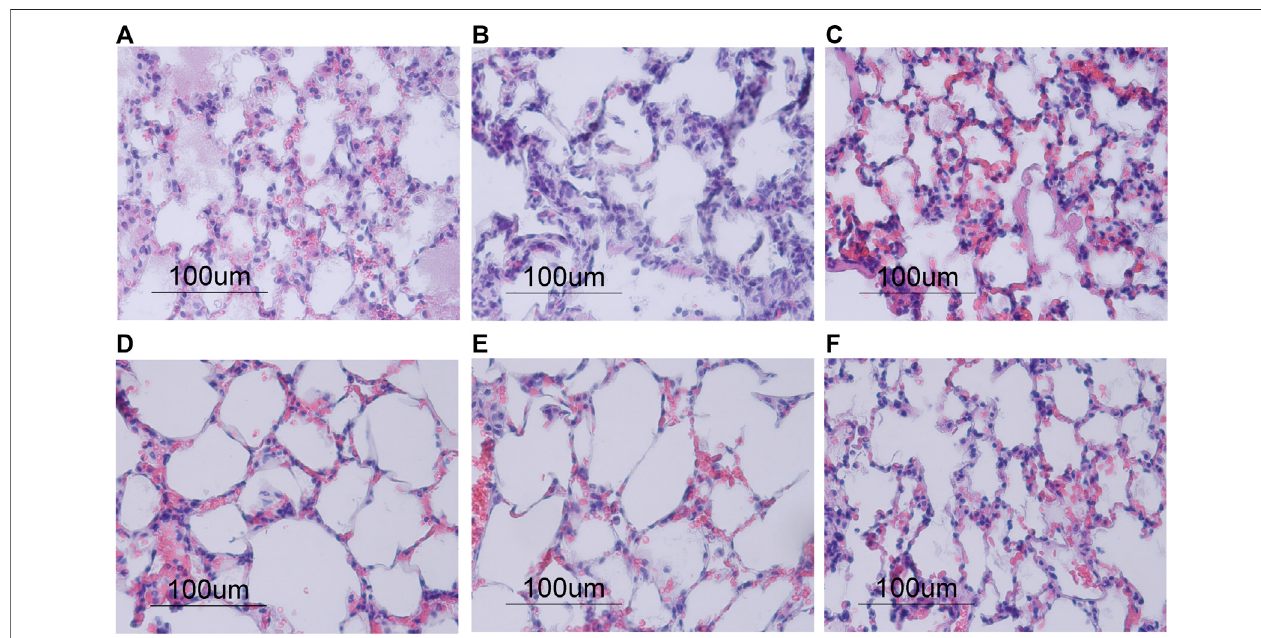
FIGURE 5 | Morphological changes in lung tissue stained with hematoxylin and eosin after 4 h of ventilation, shown in ×40 magni fi cation. (A – C) Normocapnia groups showed an increase in polymorphonuclear (PMN) cell in fi ltration compared to the hypercapnia groups (D – F) . Conventional Normocapnia (A) and Conventional HV E Normocapnia (C) showed signi fi cant pulmonary edema (e), PMN cell in fi ltrates (p), hemorrhages (h), with prominent hyaline membranes (hm) in Conventional HV E Normocapnia (C) . Protective Normocapnia (B) showed a reduction in air space size (a). (D – F) Conventional iCO 2 Hypercapnia (D) and Protective iCO 2 Hypercapnia (E) showed larger and well-in fl ated air spaces (a) and less PMN in fi ltrates (p), however both produced hemorrhages (h). Protective EDG Hypercapnia (F) produced a loss in air spaces (a), some pulmonary edema (e) and PMN in fi ltrates (p).